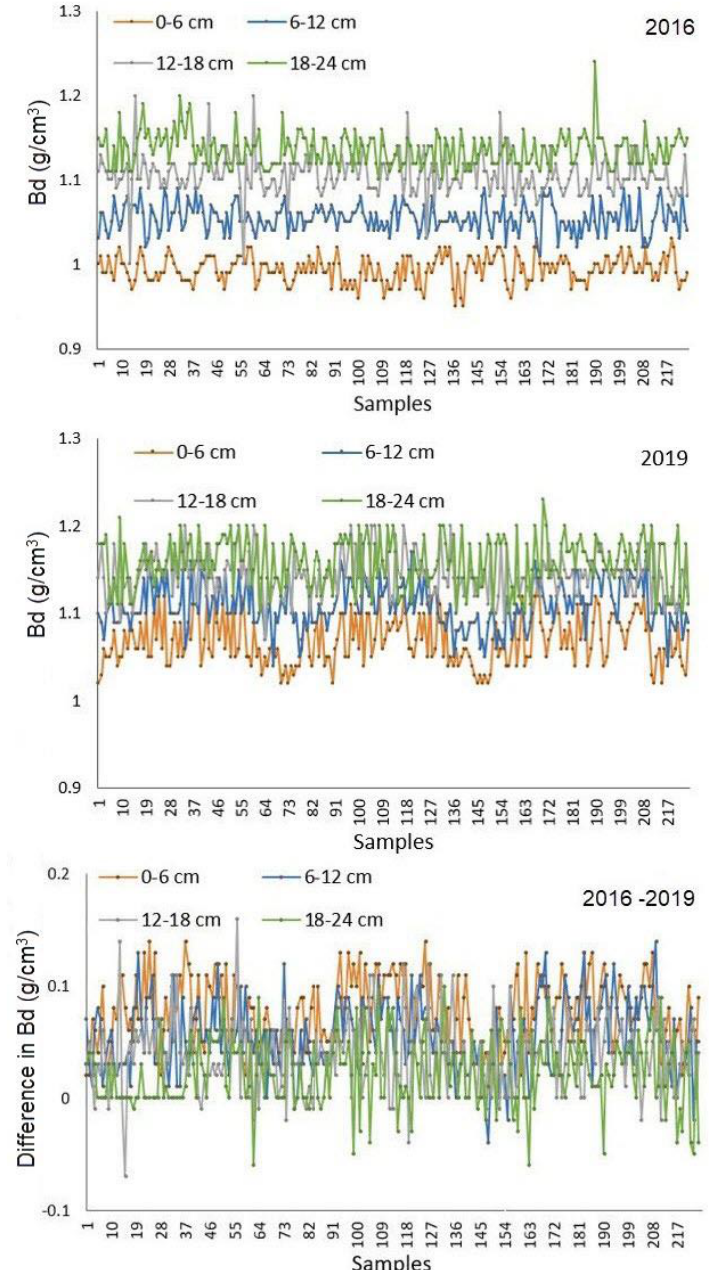
Figure 3. Changes in the Bd samples measured using 100 cm 3 steel rings at the three inter-rows in the persimmon orchard, and four different depths: 0 – 6, 6 – 12, 12 – 18 and 18 – 24 cm.